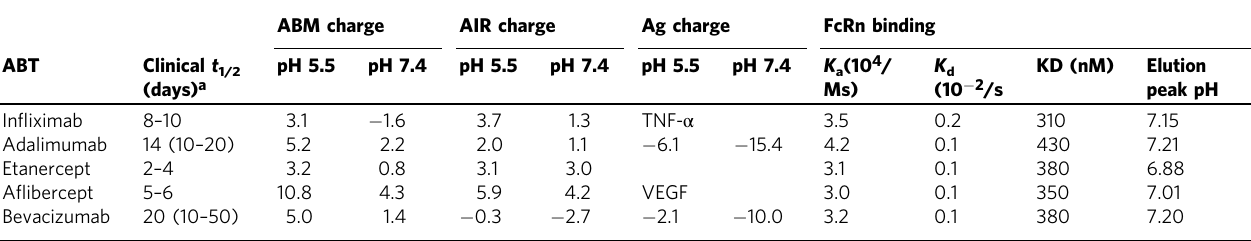
Fig. 2 Circulatory properties of IgG1 Fc and Fc-fusions in hFcRn transgenic mice. a Elimination curves and estimated β -phase half-life of the IgG1 Fc fragment (shown in red), a fl ibercept (shown in dark purple) and etanercept (shown in teal) in homozygous Tg32 mice. b Molar amounts at the start of the β -phase (1 day after IV injection). n = 5 individual mice per group. ** p < 0.005, *** p < 0.0005, **** p < 0.0001 (two-tailed, unpaired Student ’ s t test). Data show mean values ± SD. Table 1 Clinical half-lives, charge parameters and FcRn-binding capacities of ABTs and their cognate